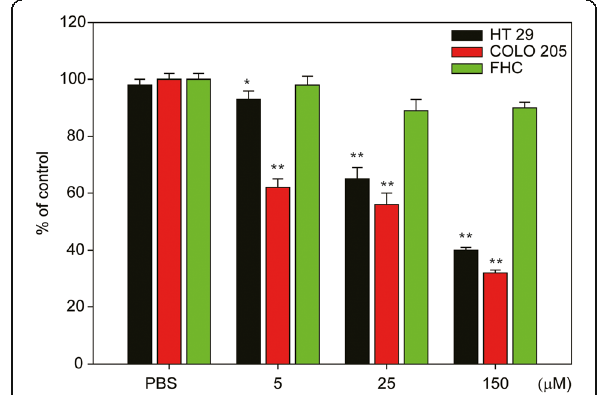
Fig. 4 Dose-dependent response of the cytotoxic effects of human colon cancer and normal cells treated with AP-02. Viability of HT 29 and COLO 205 human colon cancer cells, as well as that of FHC (normal colon epithelial) cells, was evaluated after treatment with various concentrations of AP-02 (5 – 150 μ M) for 12h. Three samples were repeated in each group, and results are shown as the means ±